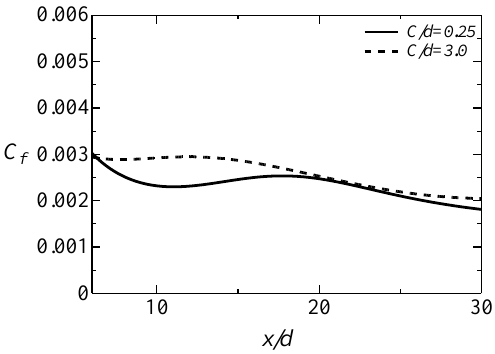
Fig. 6 Distribution of skin friction